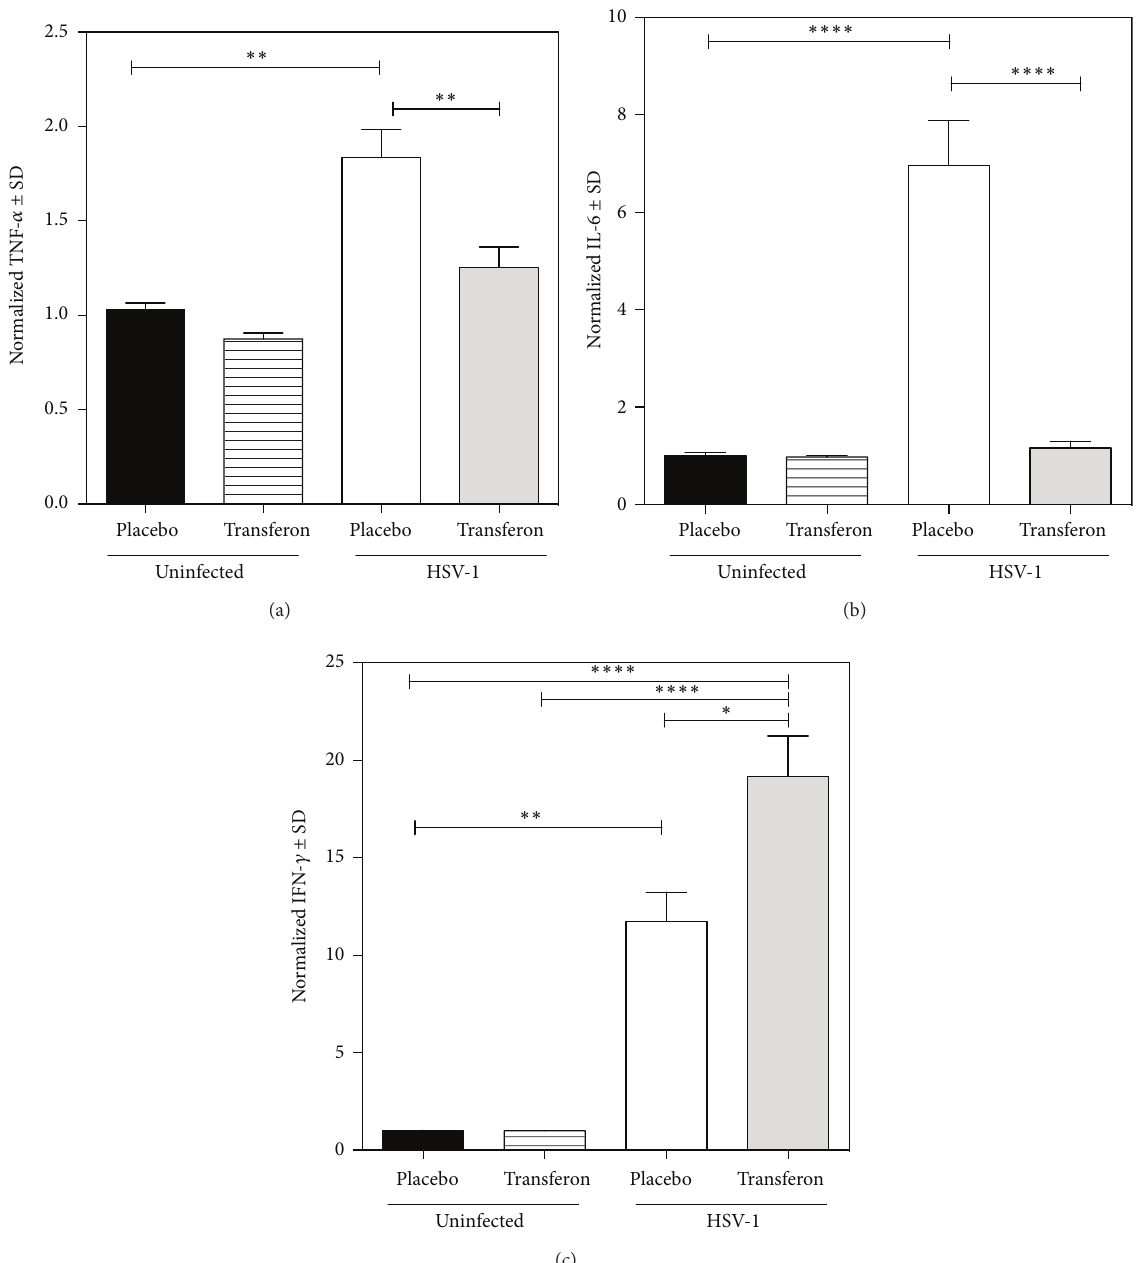
Figure 5: Quantitative analysis of blood (serum) cytokine levels. Transferon (Batch 12C04; 0.75 𝜇 g/mouse) significantly reduced the concentrations of TNF- 𝛼 (a) and IL-6 (b) at day 9 postinfection, but it increased that of IFN- 𝛾 at day 7 (c). Transferon administration had no effect on uninfected mice. All measurements were normalized to placebo-treated, uninfected controls. The graphs represent data of 2 independent experiments (ANOVA, Bonferroni’s Multiple Comparison Test; ∗ 𝑃 < 0.05 ; ∗∗ 𝑃 < 0.01 ; ∗∗∗ 𝑃 < 0.001 ; ∗∗∗∗ 𝑃 < 0.0001 ).